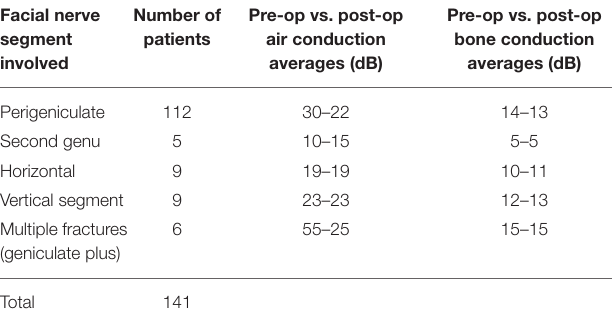
TABLE 3 | Sites of injury vs. hearing improvement in 140 patients after facial nerve decompression with ossiculoplasty. Facial nerve segment involved